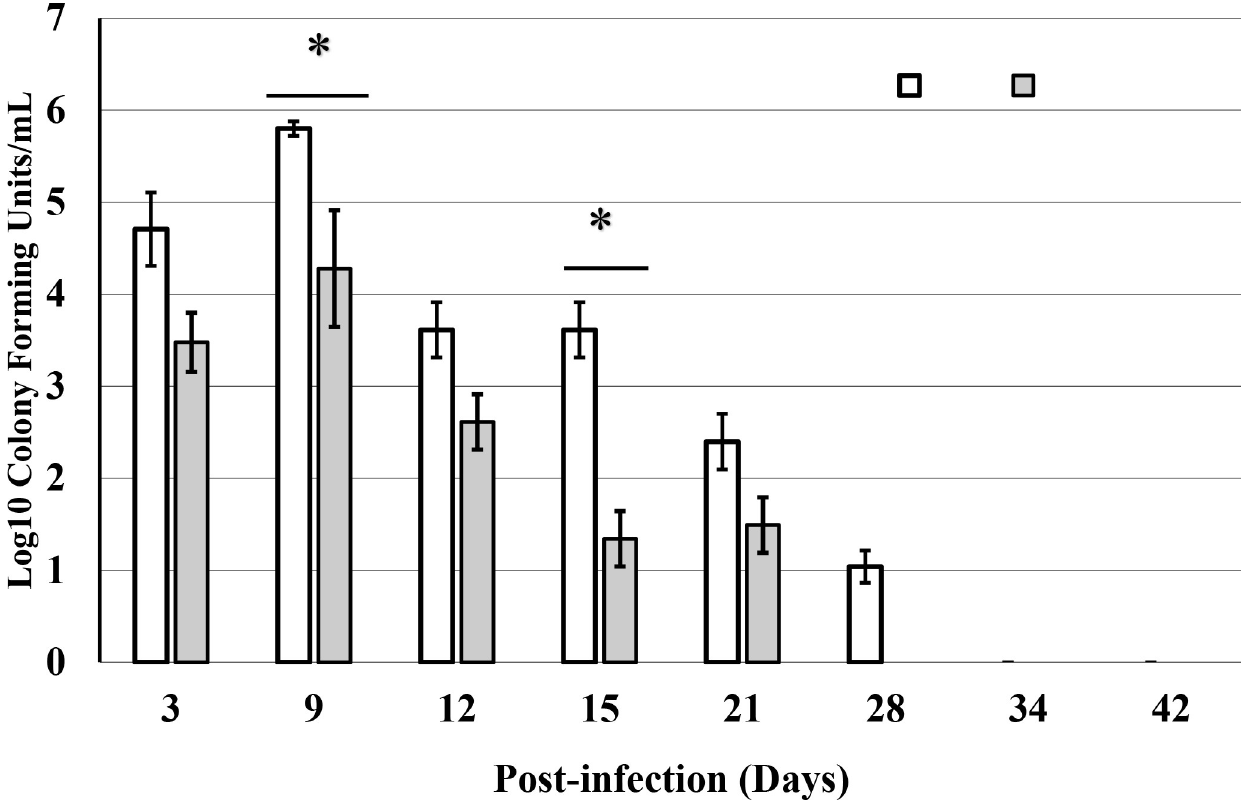
Fig 1. Course of C . muridarum genital infection in stressed and non-stressed mice as measured by quantitation of viable organisms shed from the genital tract. Each data is mean +/_ SEM of inclusion forming units/milliliter determined from McCoy cell culture representing combined results of two separate experiments (n = 5 mice per group). A statistical difference in counts was observed between stressed and non-stressed mice on day 9 and 15 after infection (p < 0.05). Shedding of C. muridarum in non-stress mice or stressed mice after day 28, indicating the resolution of infection.